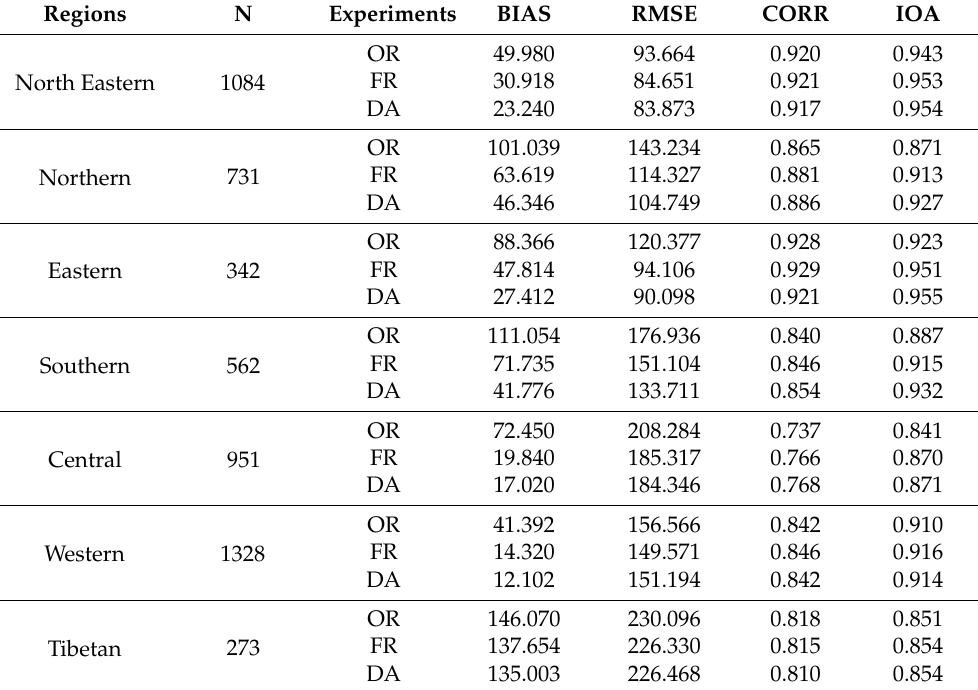
Table 3. The comparison of the hourly observational GHI with simulated ones in OR, FR, and DA experiments in seven electricity regions, only rural and suburban stations are analyzed.